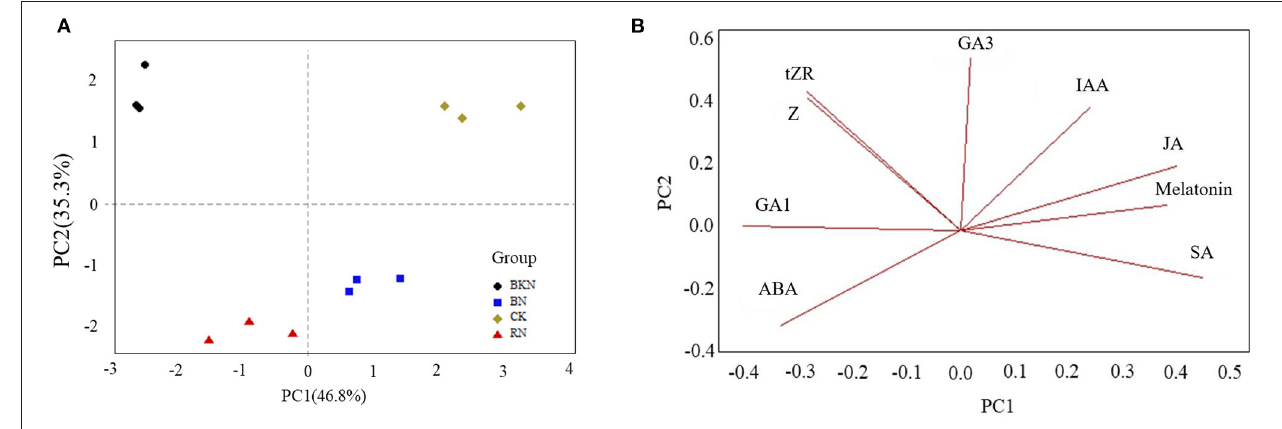
FIGURE 1 | The PCA score plot (A) and loading plot (B) of tea leaves under different shading treatments based on the levels of endogenous phytohormones.